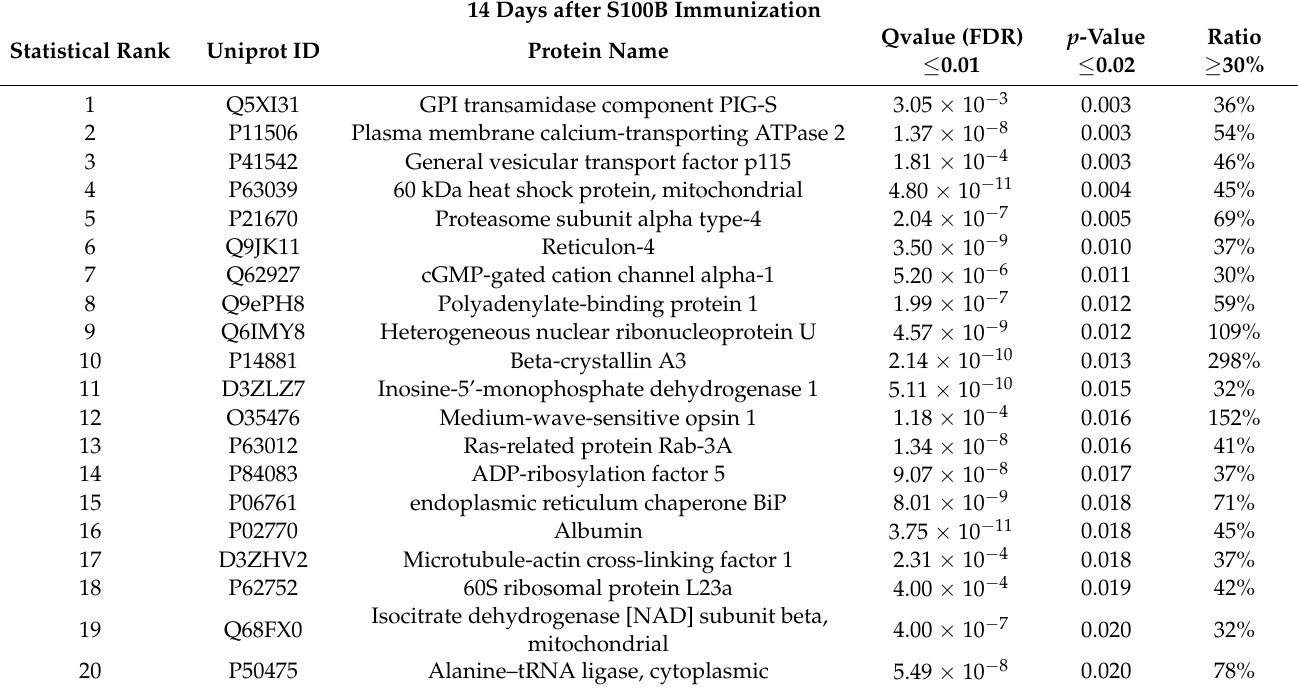
Table 2. The top 20 differential proteins 14 days after S100B immunization. Proteins that are quantified in ≥ 80% of the S100B and control groups are ranked based on the lowest p -value ( ≤ 0.02). 14 Days after S100B